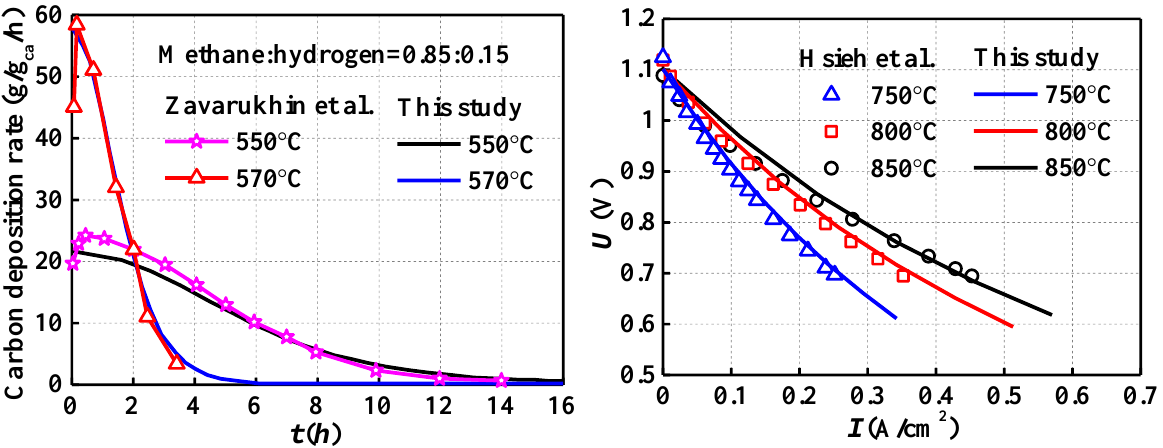
Figure 2. Comparison of simulated and experimental carbon deposition rates and polarization curves for SOFCs under different temperatures and pressure of 1 atm with data from Ref. [32,35].